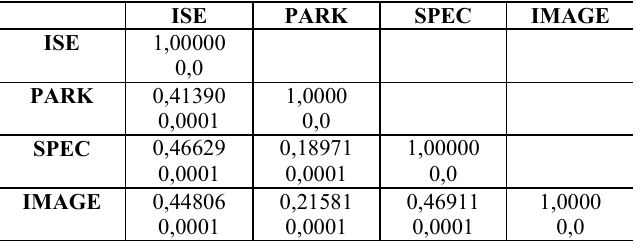
Table 3: Correlation matrix of in-store shopping